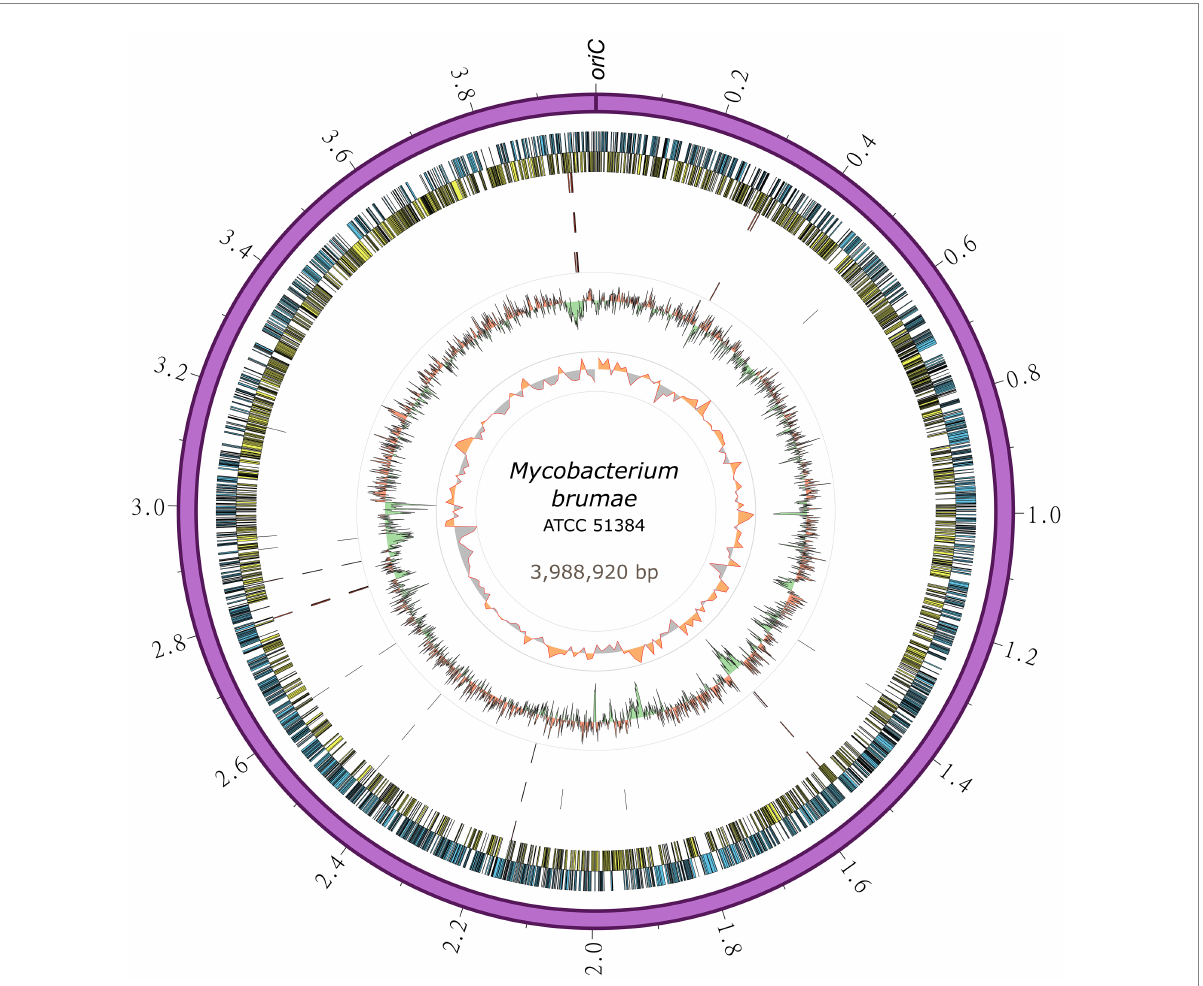
FIGURE 2 Circular representation of the Mycobacterium brumae chromosome. The outermost ring shows the chromosome length in megabases, followed by the forward (blue) and reverse genes (yellow). SNPs in M . brumae strains (CR269, CR142, and CR103) with respect to the ATCC 51384 T reference genome is indicated in the next three rings, respectively. Moving inward, the next ring shows the GC content, with values over the mean filled in red and values below the mean in green. The last ring shows the GC skew (G − C)/(G + C) using a 20-kb